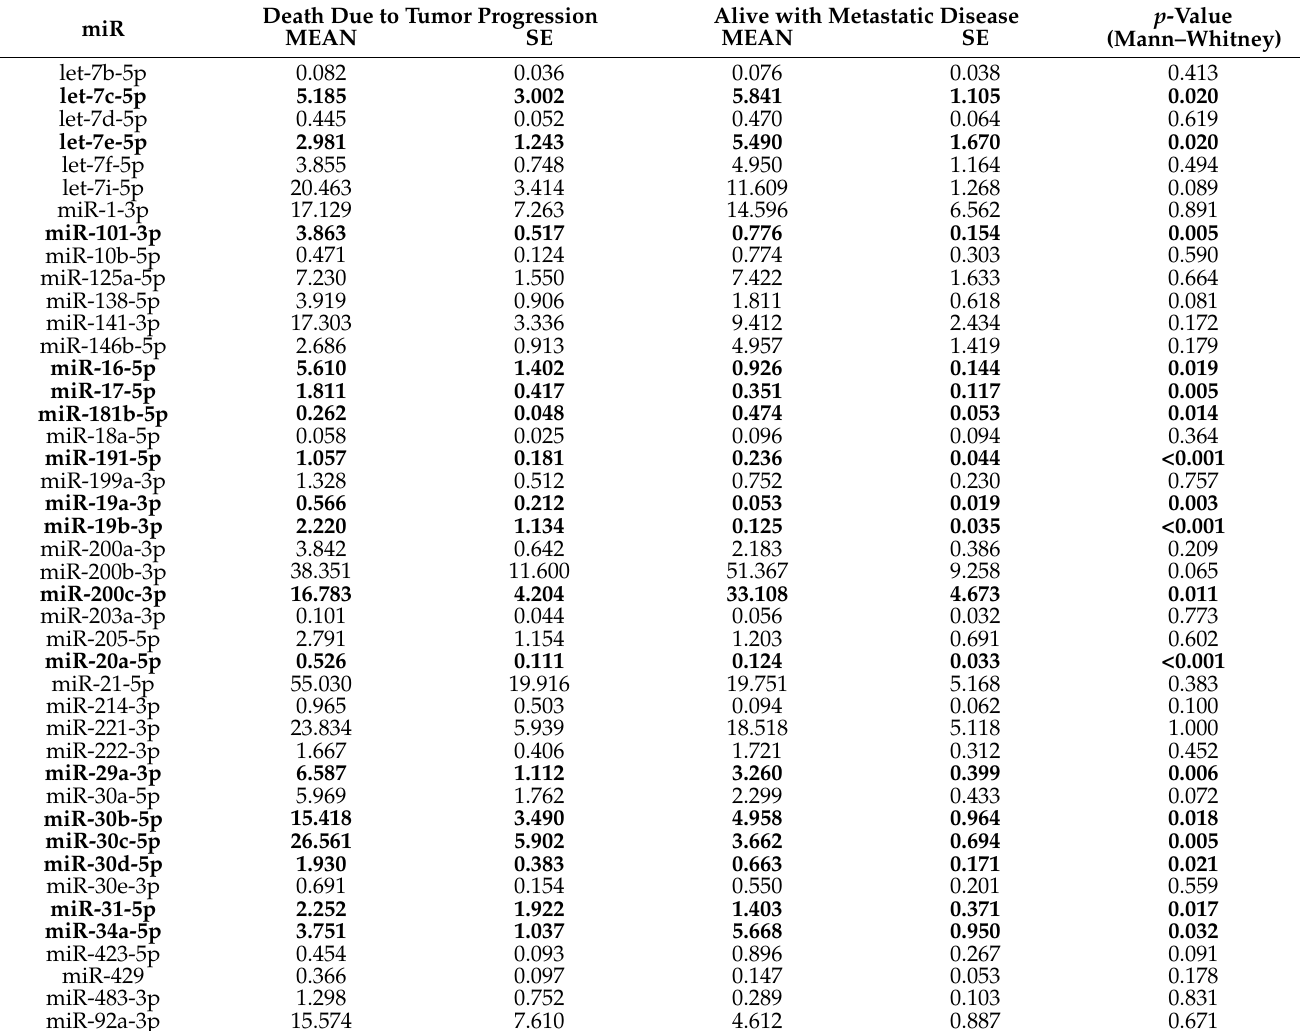
Table 2. MicroRNAs differently expressed between death patients due to progression of metastatic papillary thyroid carcinoma and those alive with stable metastatic disease (without tumor progression at long